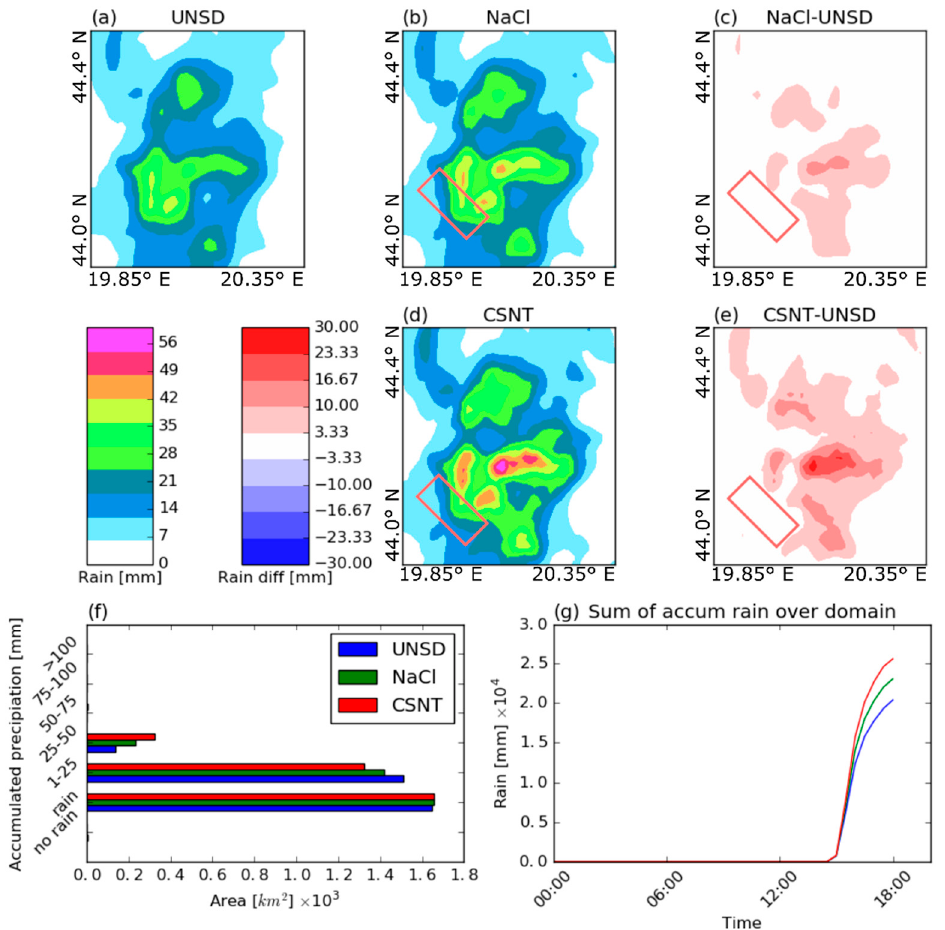
Figure 10. Spatial distribution of accumulated precipitations for the arid case of the Serbia for ( a ) the unseeded case (UNSD), ( b ) core/shell sodium chloride (NaCl) and ( d ) sodium chloride (NaCl)/titanium dioxide (TiO 2 ) nanostructure (CSNT) cases. The red rectangle shows the seeding region. The differences between the accumulated precipitation in the cases shown in panels ( c ) and ( e ). ( f ) Bar plot of areas characterized with different intensities of accumulated precipitations. ( g ) Time histories of accumulated precipitation in the UNSD (blue), NaCl (green) and CSNT (red) cases.